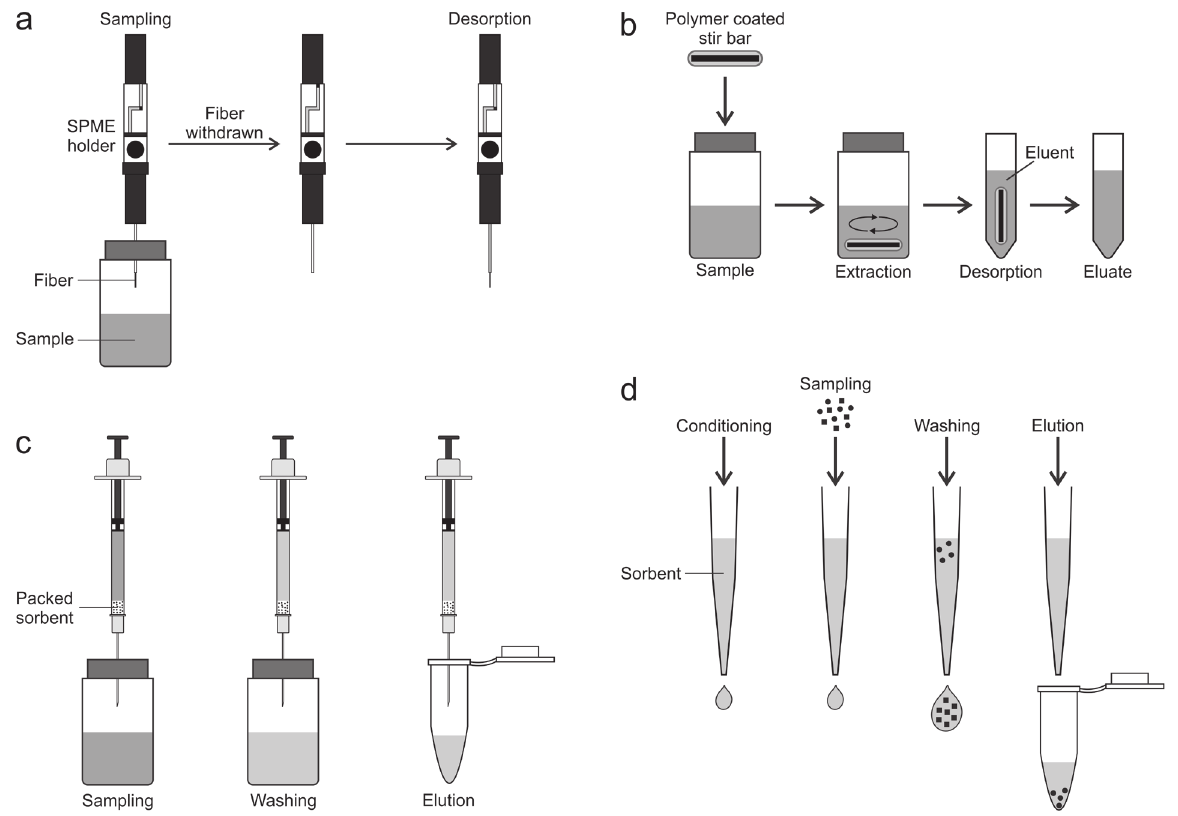
Figure 1 – Schematic representation of approaches for solid-phase green sample preparation: ( a ) SPme, ( b ) SBSe, ( c ) mePS and ( d )